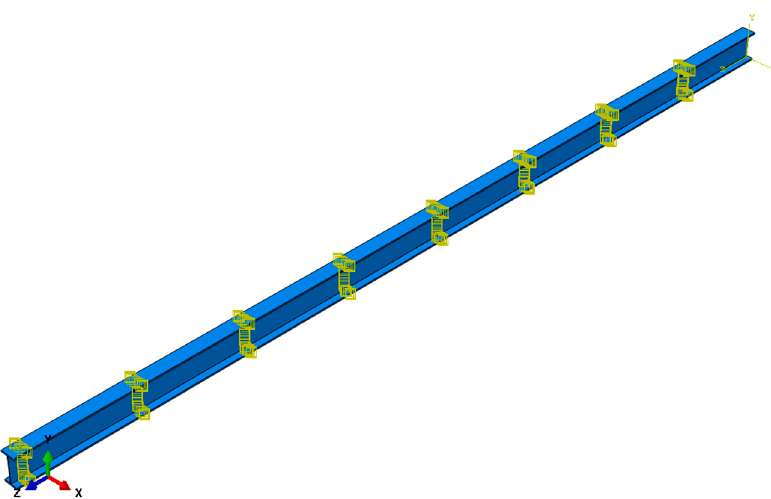
Figure 7. Thermal boundary conditions.